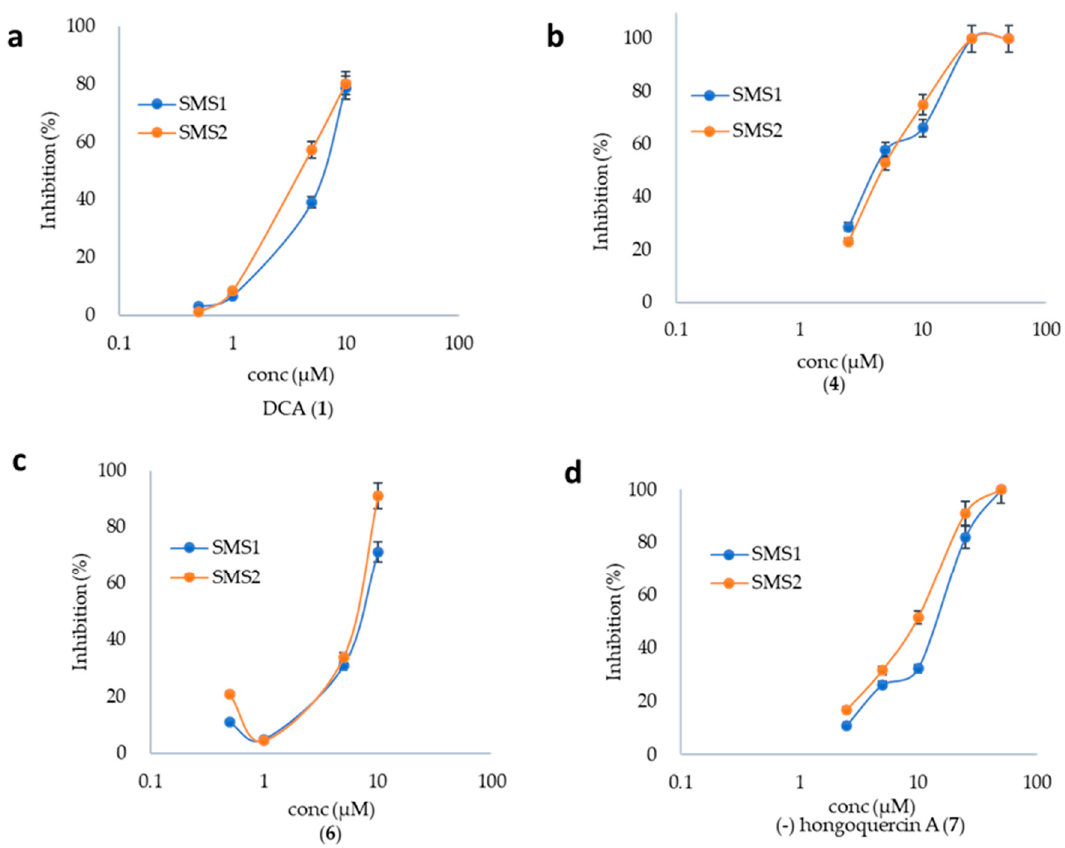
Figure 1. Inhibition of SMS1 and SMS2 activities by ( a ) DCA ( 1 ), ( b ) derivative ( 4 ), ( c ) derivative ( 6 ) and ( d ) derivative ( 7 ). IC 50 values were measured using a cell lysate assay. SMS-expressing cell lysates and compounds were incubated for 3 h at 37 °C, and the extracted fluorescent lipids were directly analyzed by HPLC. Each point represents the mean ± SD of triplicate assays.